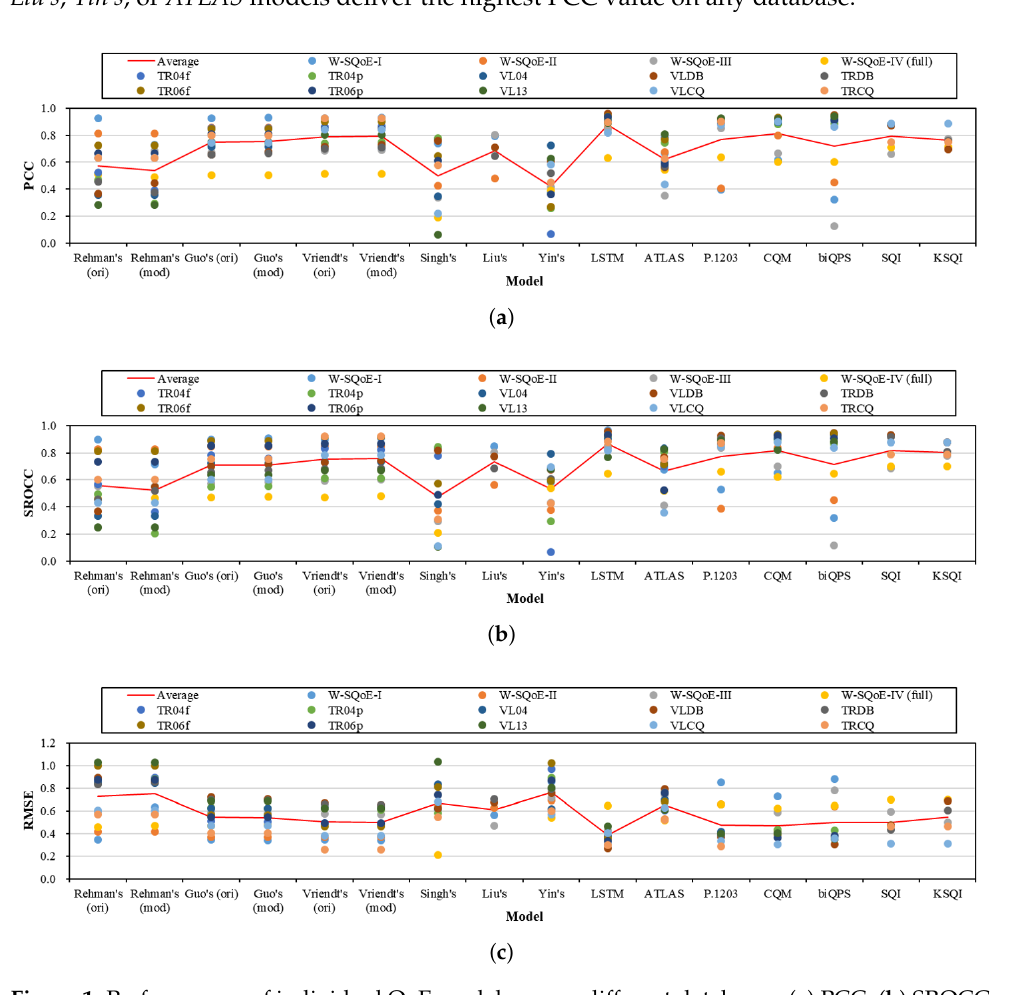
Figure 1. Performances of individual QoE models across different databases. ( a ) PCC; ( b ) SROCC; ( c )